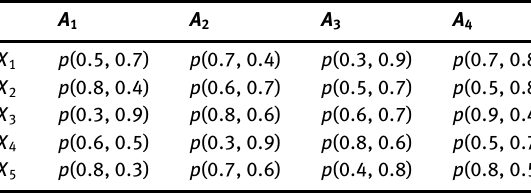
Table 2: Pythagorean Fuzzy Decision Matrix R (2)